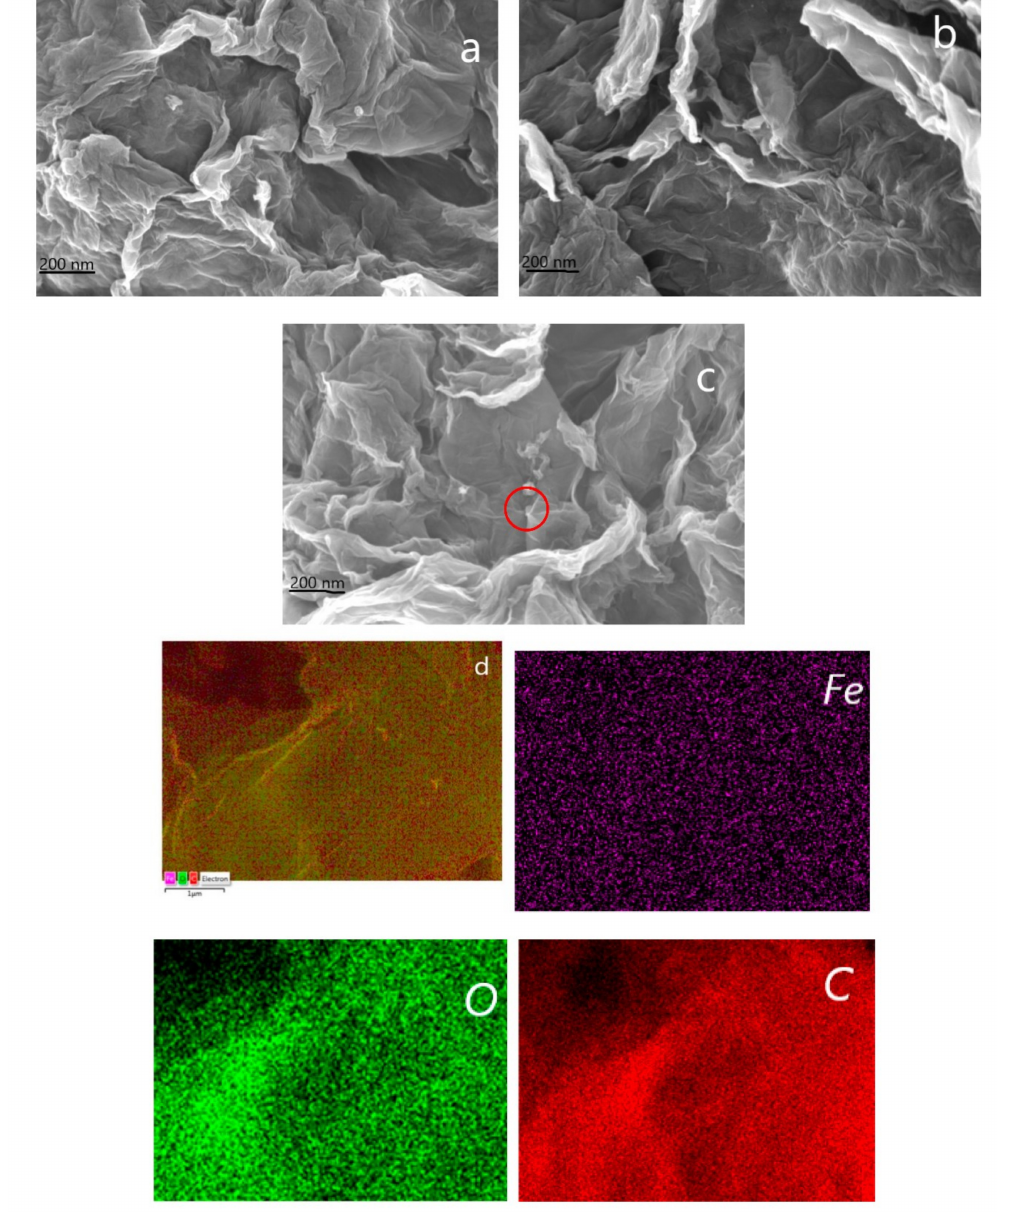
Figure 4. Surface morphology of ( a ) 10% Fe/N-rGO, ( b ) 15% Fe/N-rGO and ( c ) 20% Fe/N-rGO. ( d ) Element mapping of 20% Fe/N-rGO with its corresponding Fe, O and